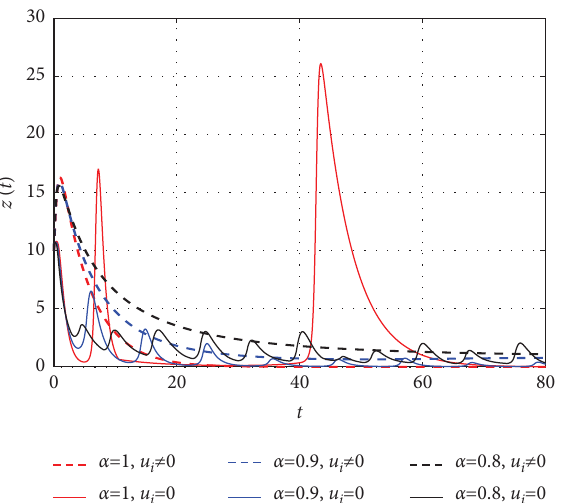
� 0 . 0005 , C � 0 . 0003 , 2 3